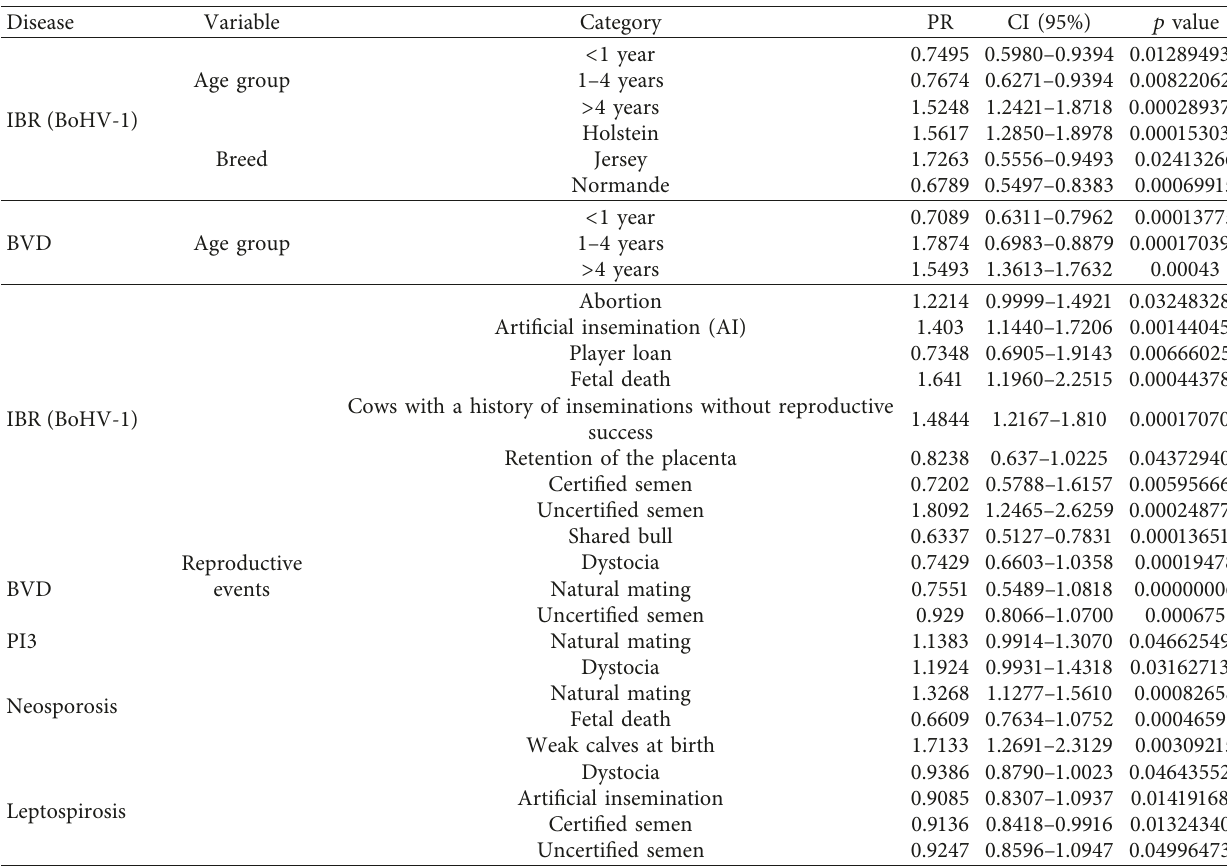
Table 3: Possible risk factors associated with IBR, BVD, PI3, neosporosis, and leptospirosis infections and results are shown as the prevalence ratio (PR) and the 95% confidence interval (95% CI). Significance is denoted by a value of p < 0 . 05.